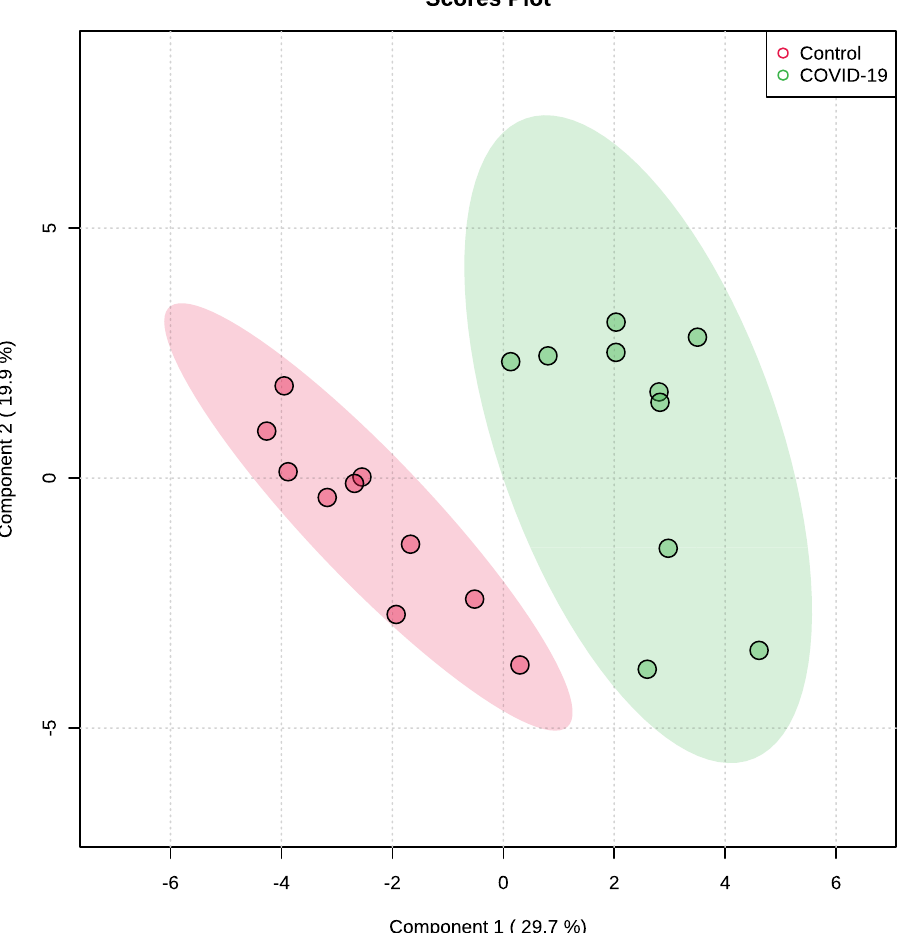
Figure 1. Partial least square-discriminant analysis (PLSD-DA), showing a robust separation among the groups (COVID-19 versus Control). Each point in the plot corresponds to a saliva sample. Source: Metaboanalyst 5.0 (https:// www. metab oanal yst.